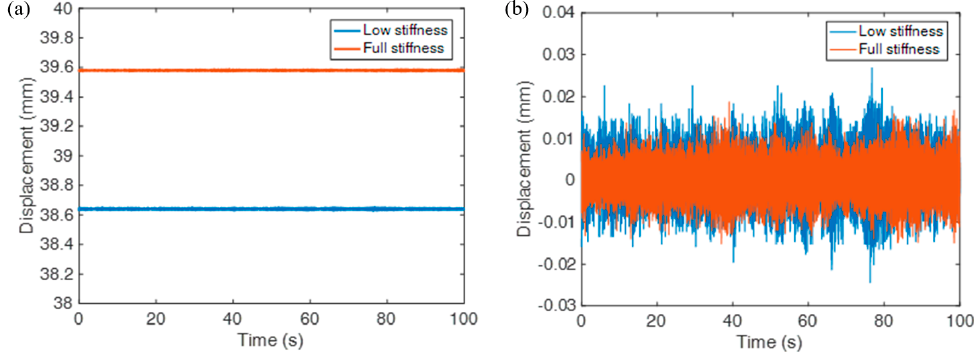
Figure 12. Effect of stiffness on the vertical displacement of the bridge: ( a ) absolute displacement and ( b ) relative displace- ment.